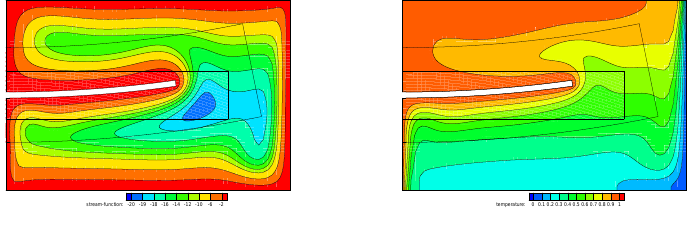
Figure 14. Stream function and Temperature for Ra = 10 6 and ρ = 6 . 5